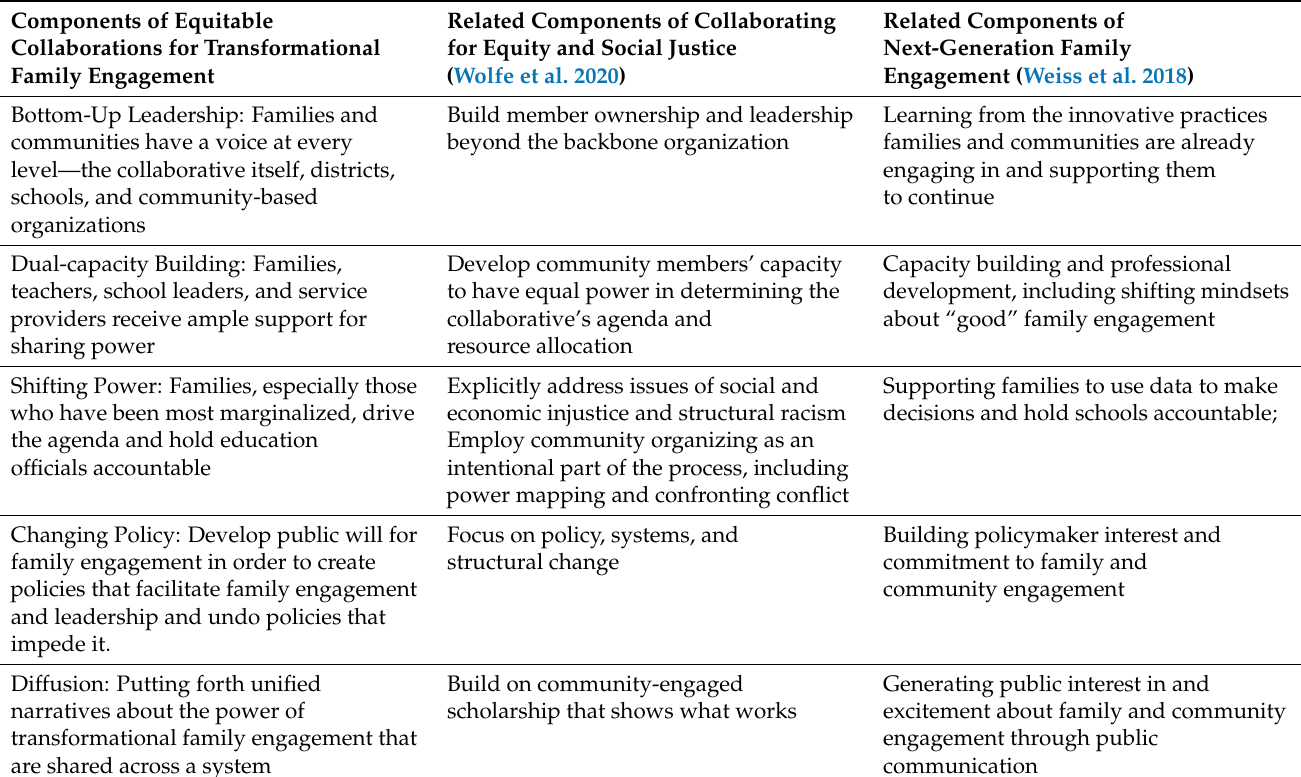
Table 4. Components of equitable collaborations for transformational family engagement and related components from models of “Collaborating for Equity and Social Justice” and “Next-Generation Family